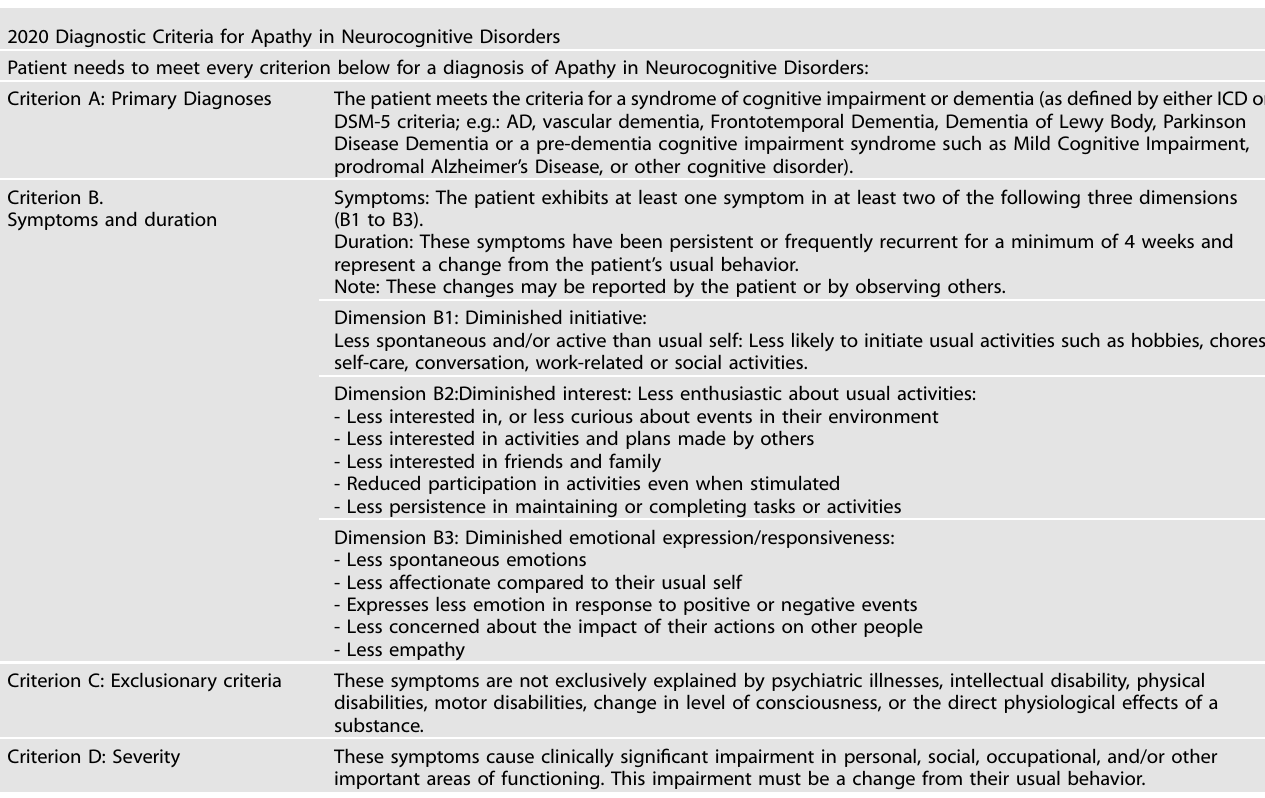
Table 1. Diagnostic Criteria for Apathy and Diagnostic criteria for apathy in neurocognitive disorders [7] (reprinted with